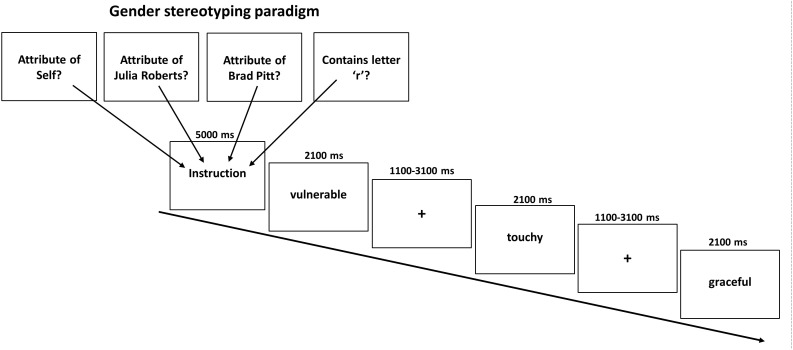
Illustration of the gender stereotyping paradigm. In four conditions typical female or male attributes had to be related to oneself or a typical woman or man. As control a letter judgment condition was used. Each instruction was displayed for 5000 ms before a block of three adjectives was shown (displayed for 2100 ms each) and separated by a jittered fixed cross between 1100 and 3100 ms.